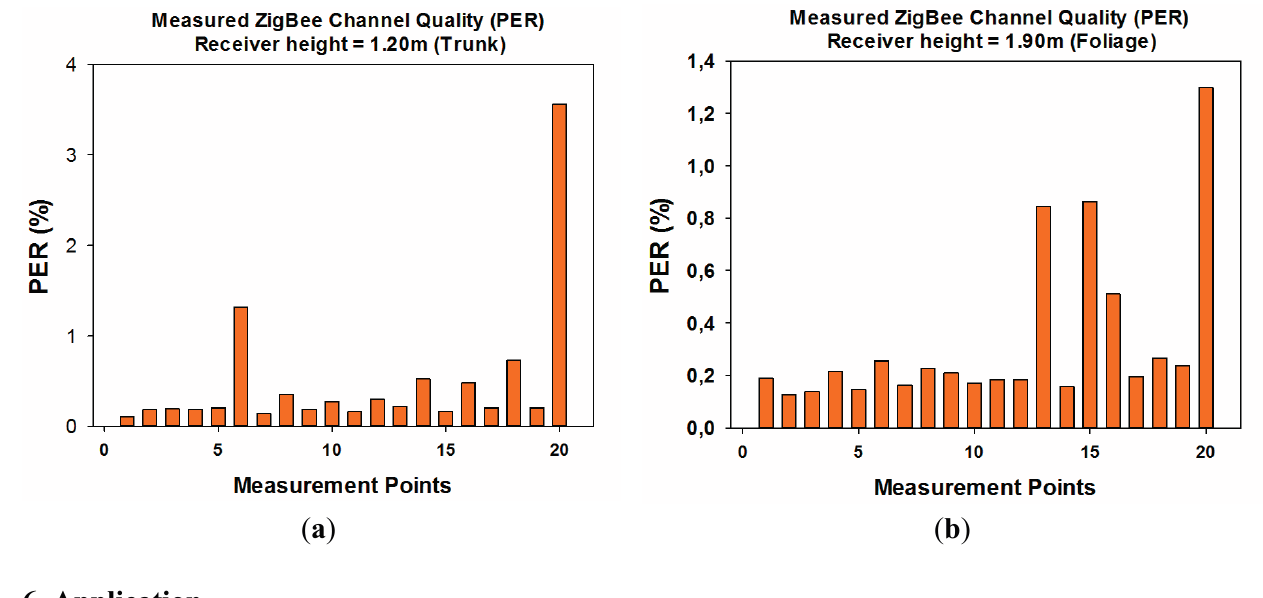
Figure 18. ZigBee wireless channel quality measurements in the considered scenario ( a ) Receiver placed at the trunk of the tree ( b ) Receiver placed within the foliage of the